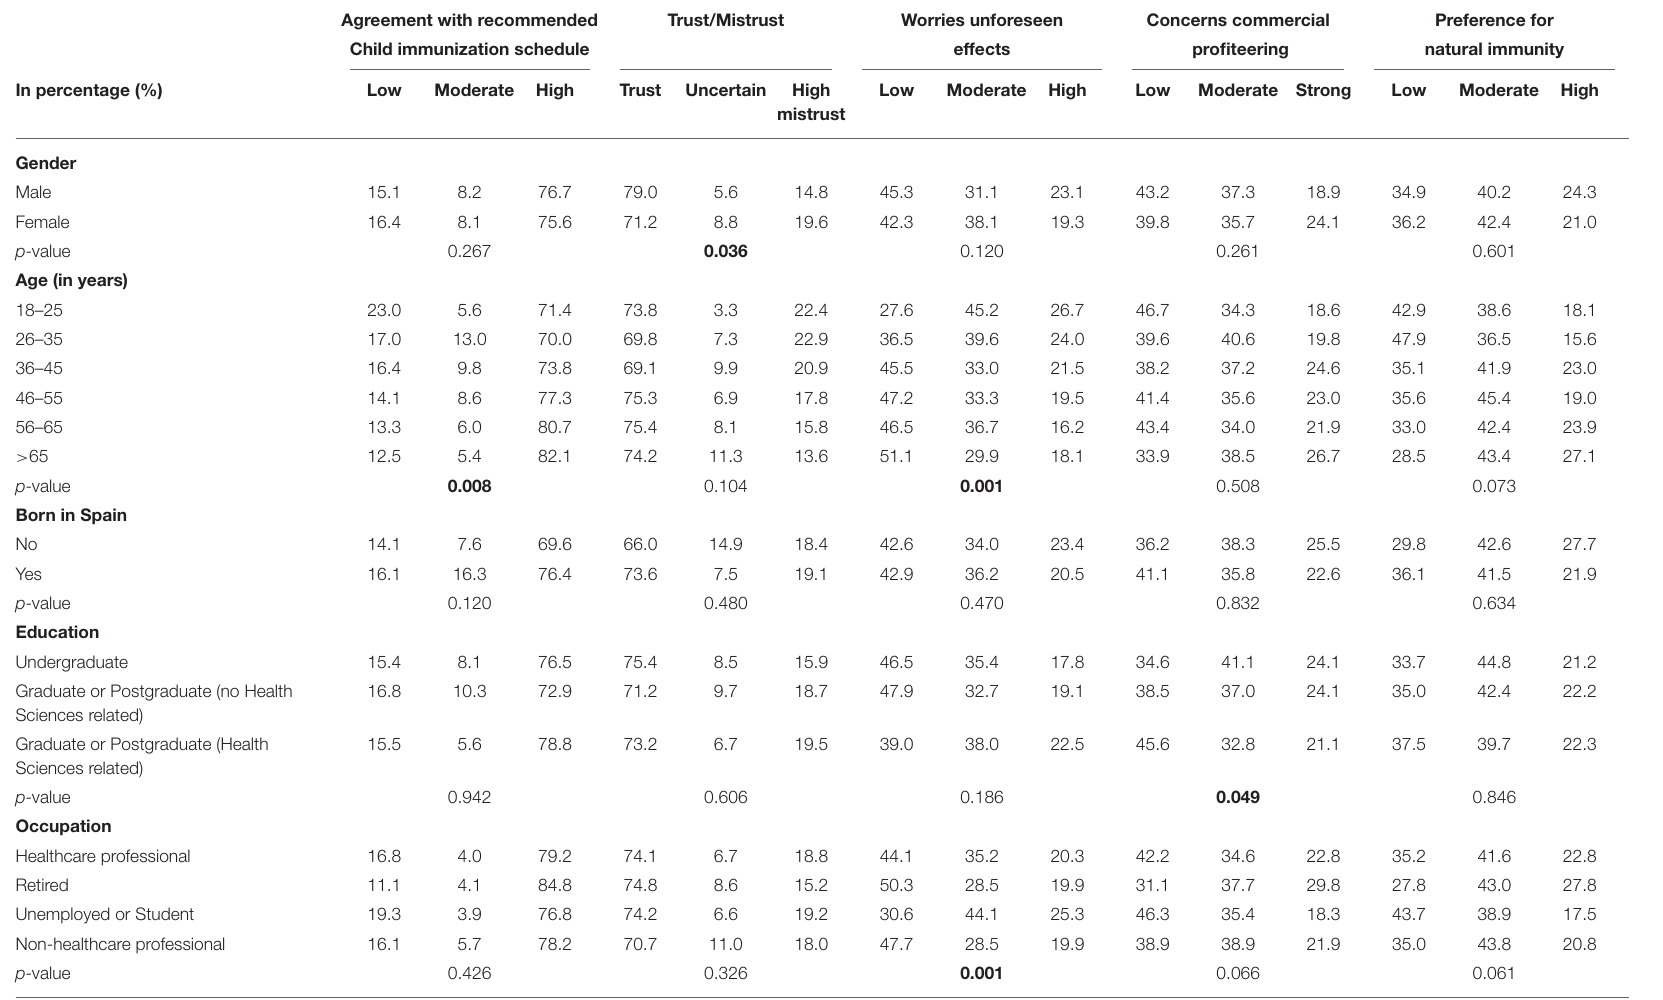
TABLE 2 | Attitudes toward vaccines (agreement with current recommended Child Immunization Schedule, trust/mistrust, worries about unforeseen effects, concerns about commercial profiteering, preference for natural immunity) by gender, age, migrant origin, education status and occupation (in percentage). Agreement with recommended